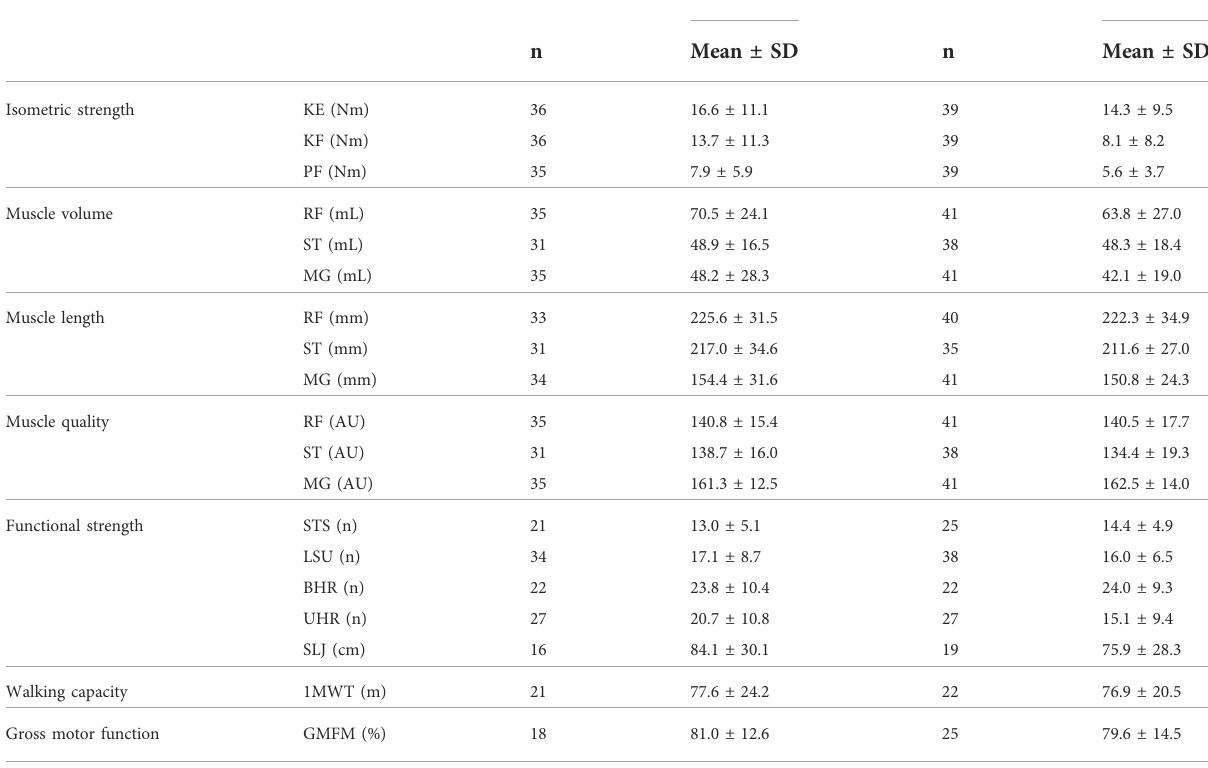
TABLE 2 Descriptive statistics of observed data at baseline for all participants, with all affected sides for unilaterally tested